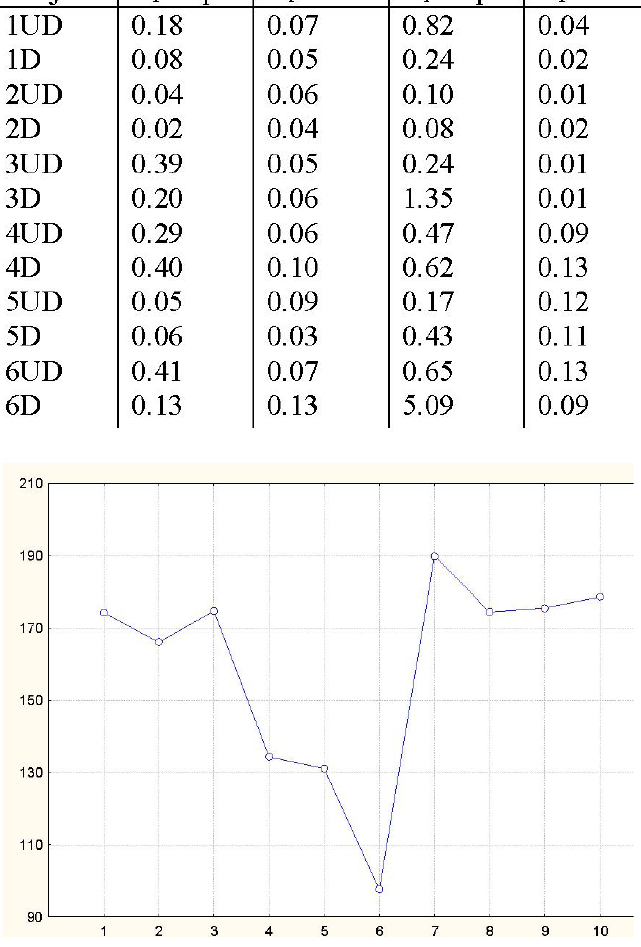
Figure 6: One example of a plot showing the ten data points of B amplitude (measured in micro-volts) for subject 1 (un-dilated 1 eye). The data are summarized in Table 1 (subject S1UD). The variation in measurements is representative of other measures. The y -axis indicates B amplitude while the x -axis indicates 1 measurement number. The variability in the measurements is